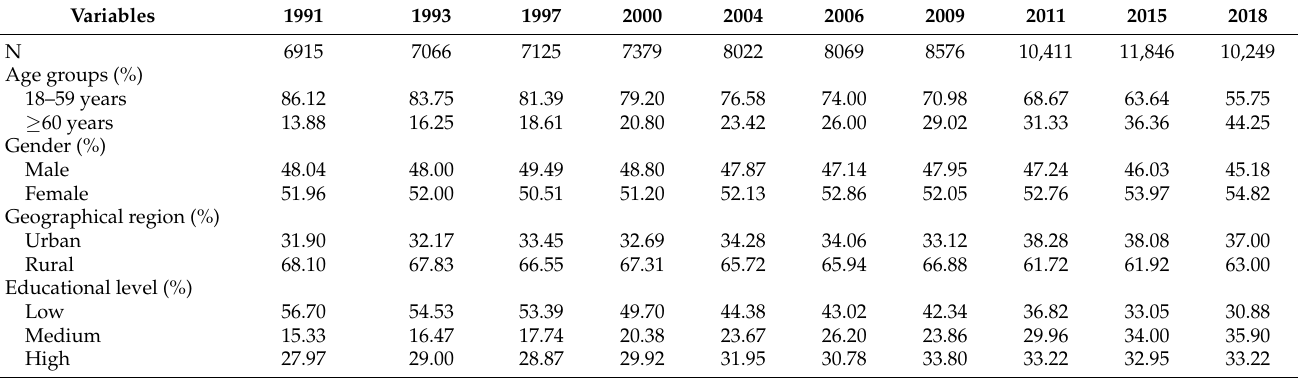
Table 1. Cross-sectional characteristics of the study sample in CHNS 1991 to